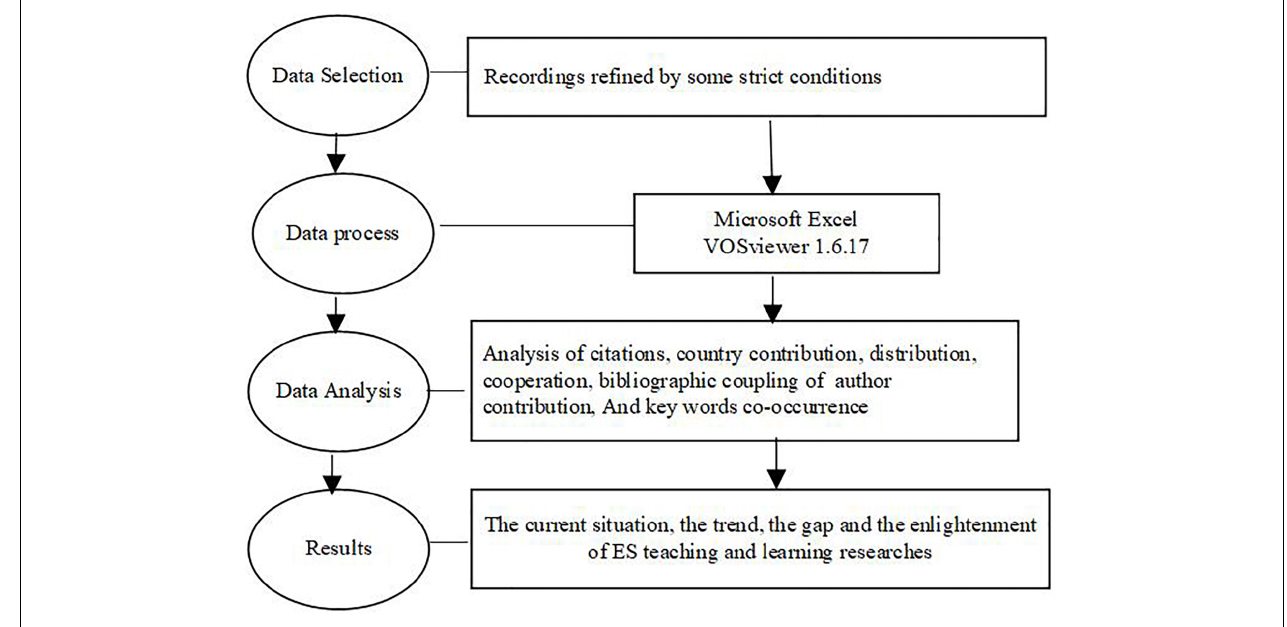
FIGURE 1 | The conceptual framework.